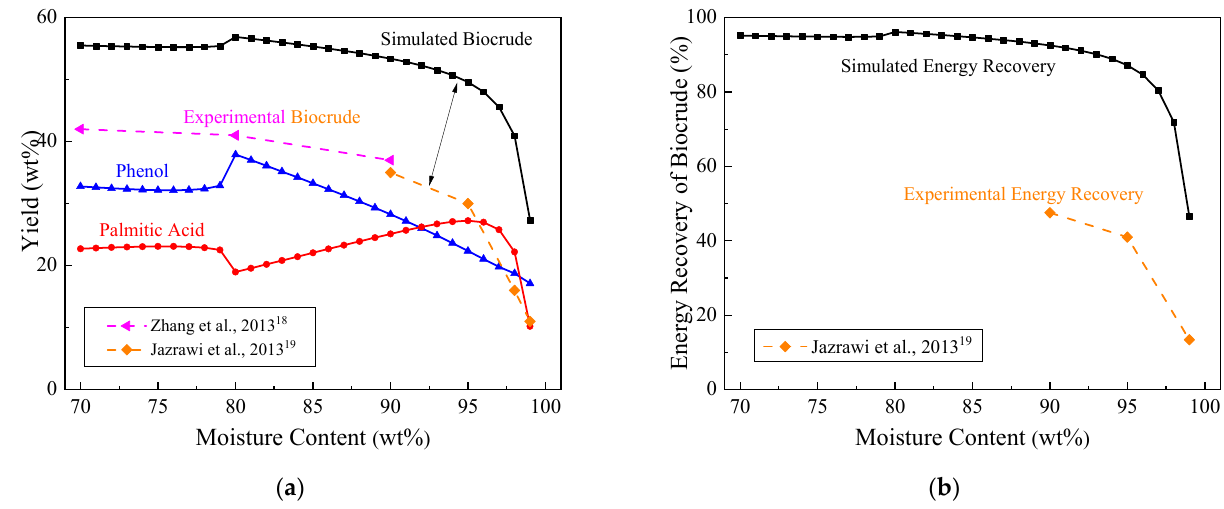
Figure 2. Effect of moisture content on: ( a ) biocrude yield; ( b ) energy recovery at 350 °C and 20 MPa.